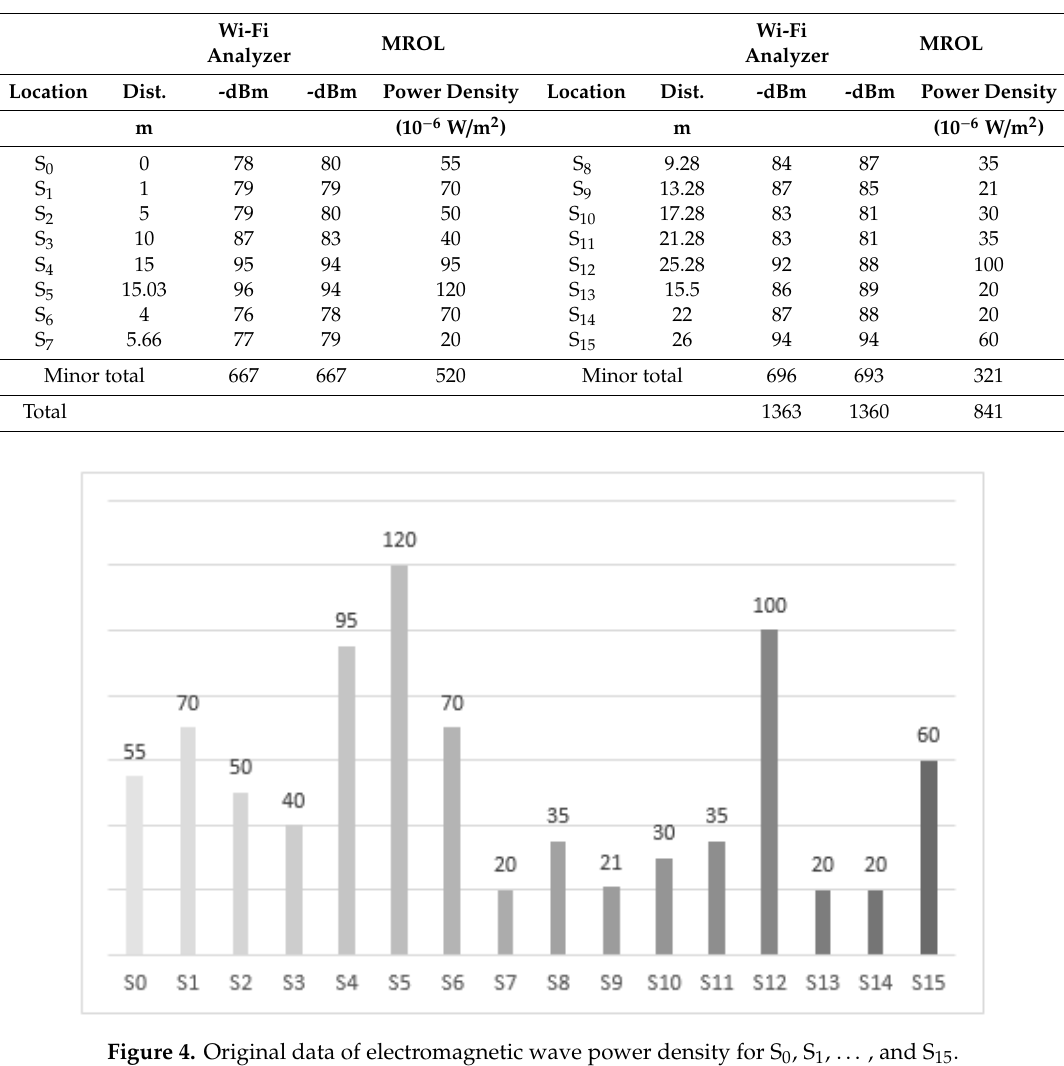
Figure 4. Original data of electromagnetic wave power density for S 0 , S 1 , …, and S 1 5 .